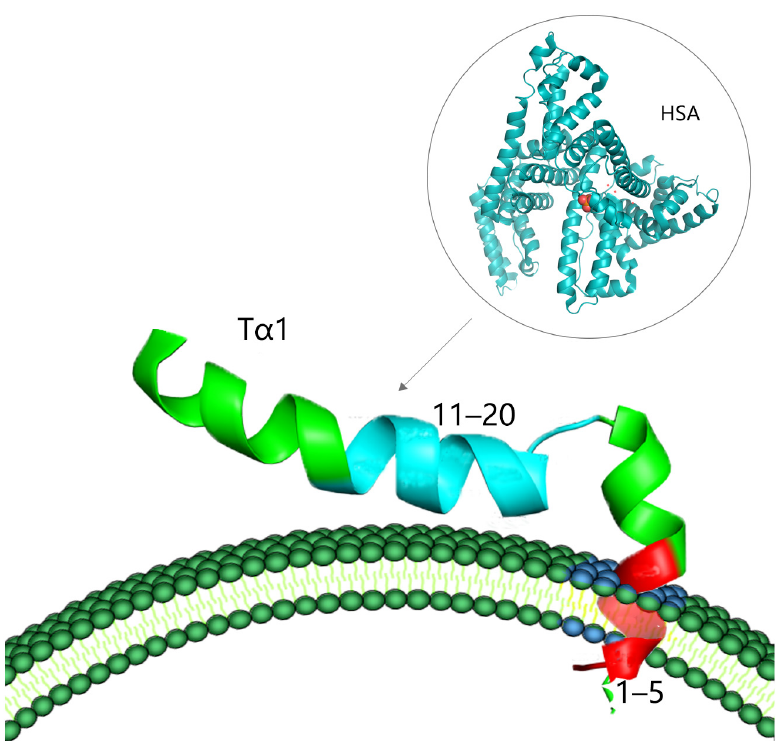
Figure 2. Possible interactions between T α 1 and the membrane (the dark blue part of the phospholipid bilayer is the negatively charged target membrane region after PS exposure, which is combined with the 1–5 amino acid residue sequence of the red part of T α 1; the 11–20 amino acid residue sequence of the blue part of T α 1 is the region interacting with HSA).